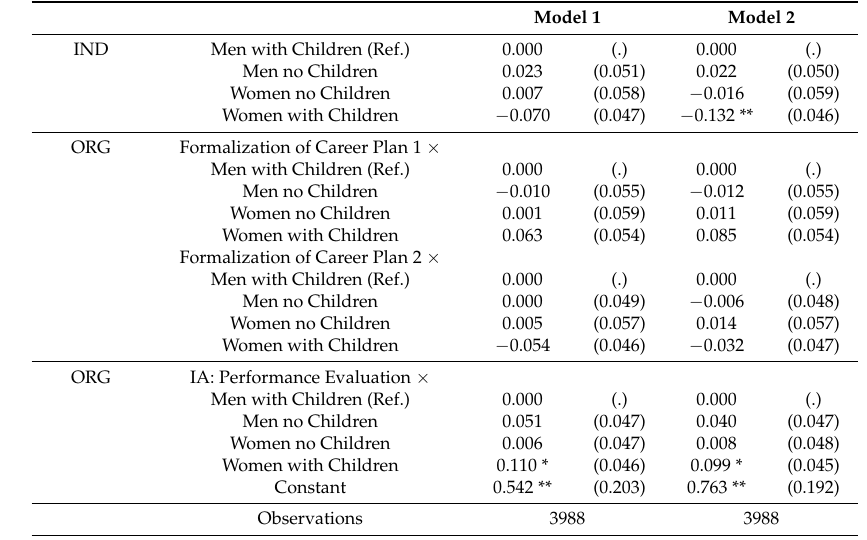
Table 7. Gender Gap in Claims-Making and Formalization of Human Resource Practices (results of linear fixed-effects